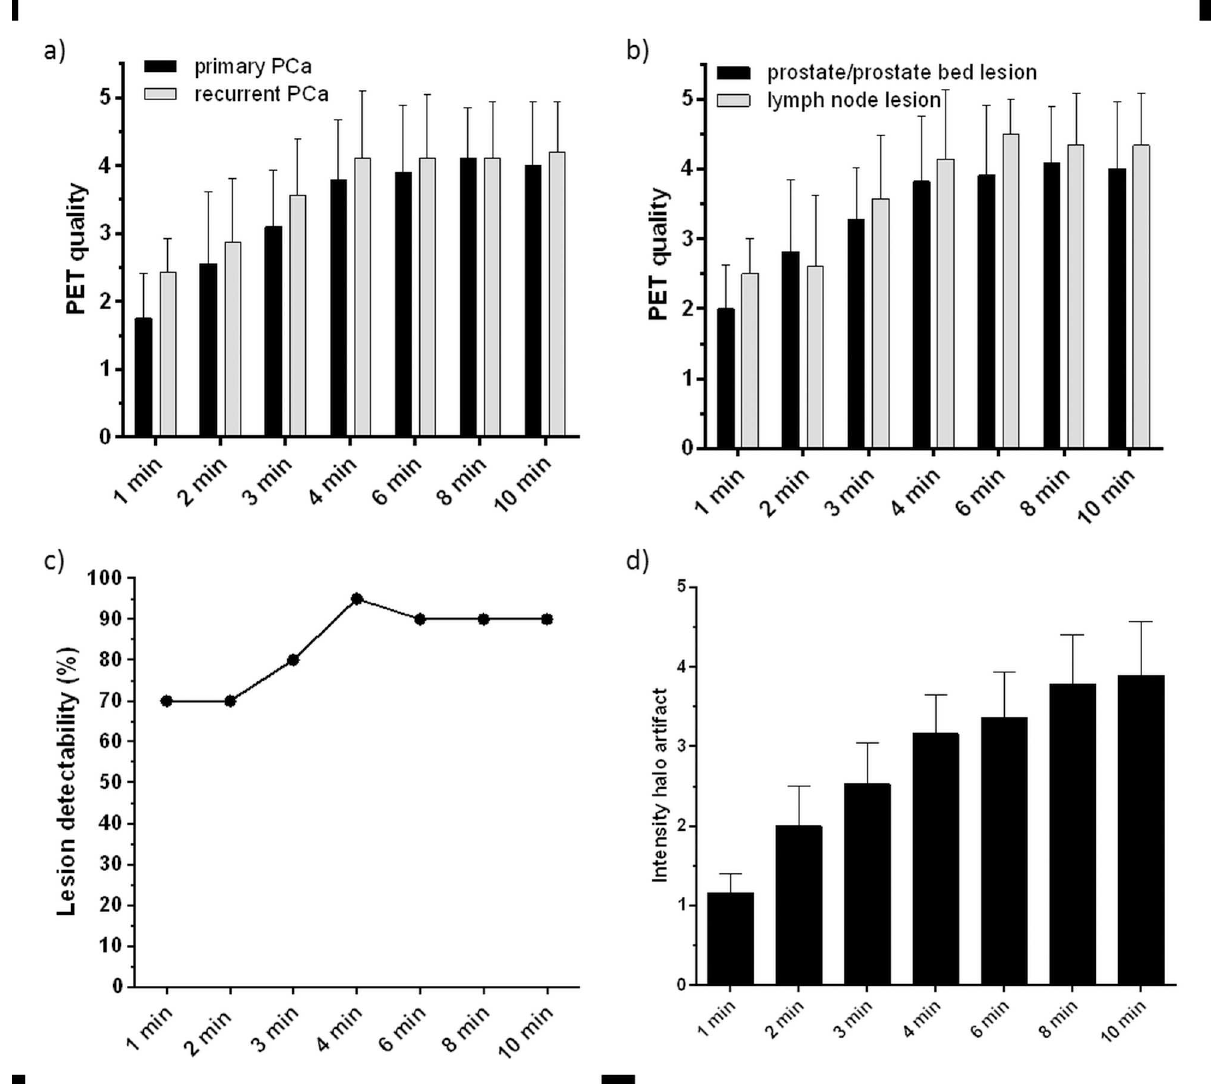
Fig 1. Quality of PET images obtained with 68 Ga-HBED-CC-PSMA PET/MRI at different acquisition times for primary (n = 10) and recurrent (n = 10) PCa lesions (a)) and prostate/prostate bed as well as lymph node lesions (b)), data are presented in mean ± SD. c) Percentage of tumor lesions detected with 68 Ga-PSMA PET/MRI at different acquisitiontimes. d) Intensity of the halo artifact on an ordinal scale from 1 (not present)– 5 (very intense halo artifact) at different PET image acquisition times. Data are presented in mean ± 95% confidence